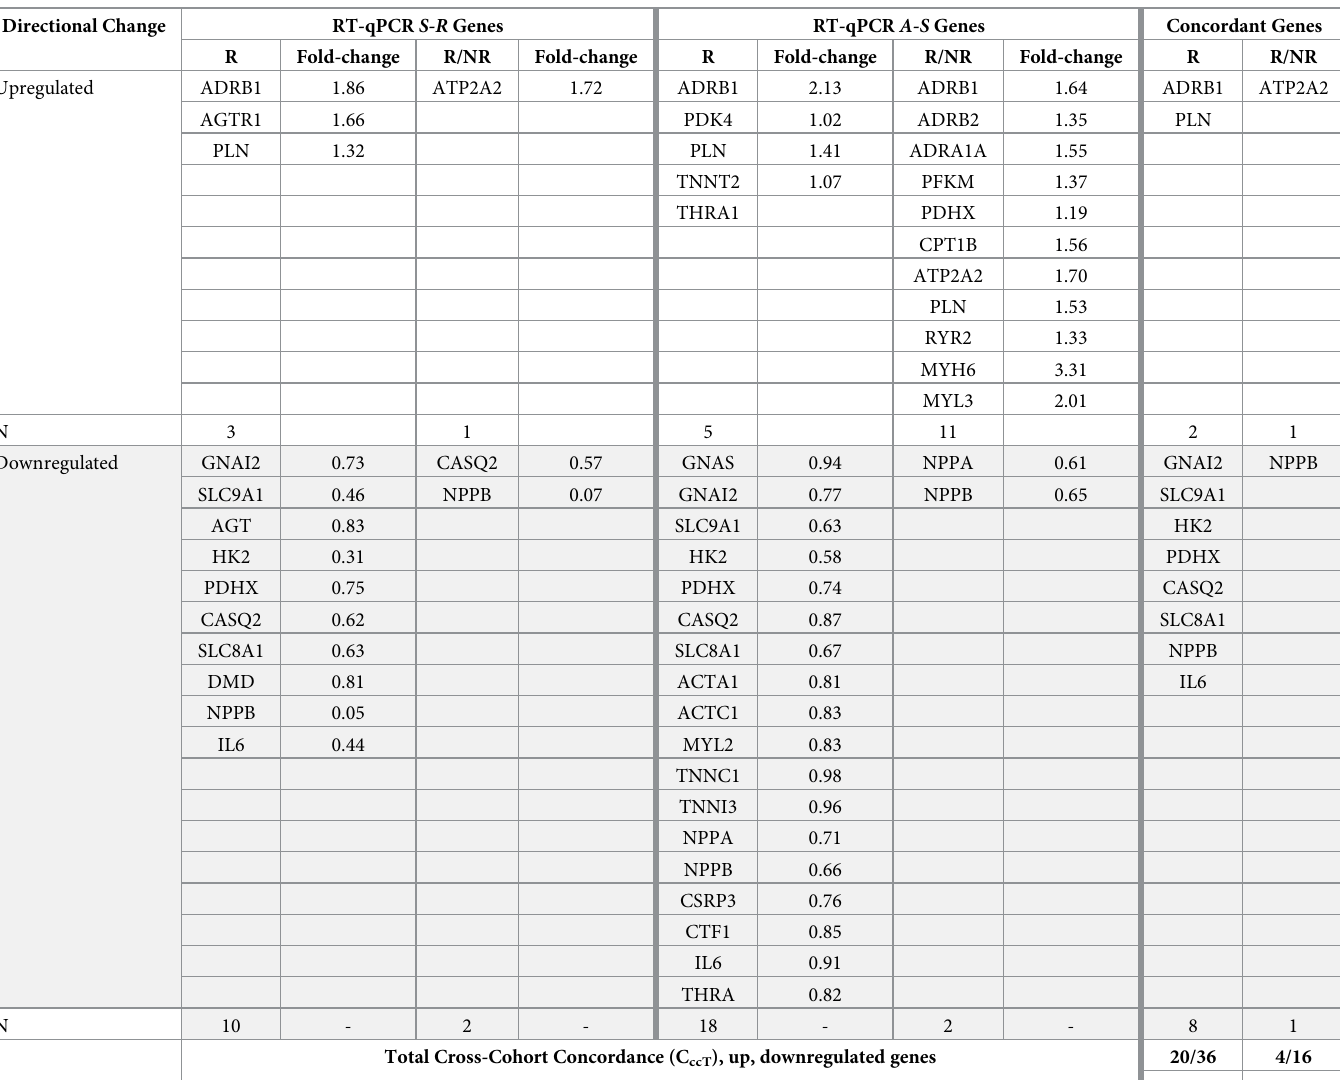
Table 5. Cross-cohort candidate gene concordance of RT-qPCR in the A-S vs. S-R cohorts (changes of P < 0.05). Directional Change Upregulated